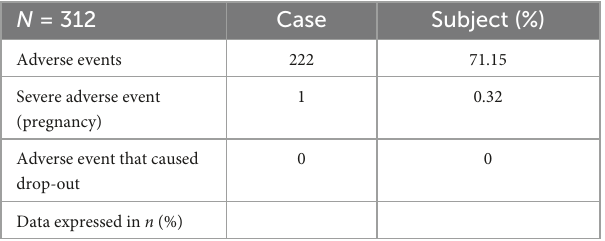
has a high risk of drug-drug interaction (27–29). Therefore, FNC treatment can not only accelerate the elimination of the virus but also reduce the time of infection since the time of nucleic acid negative conversion is shortened.